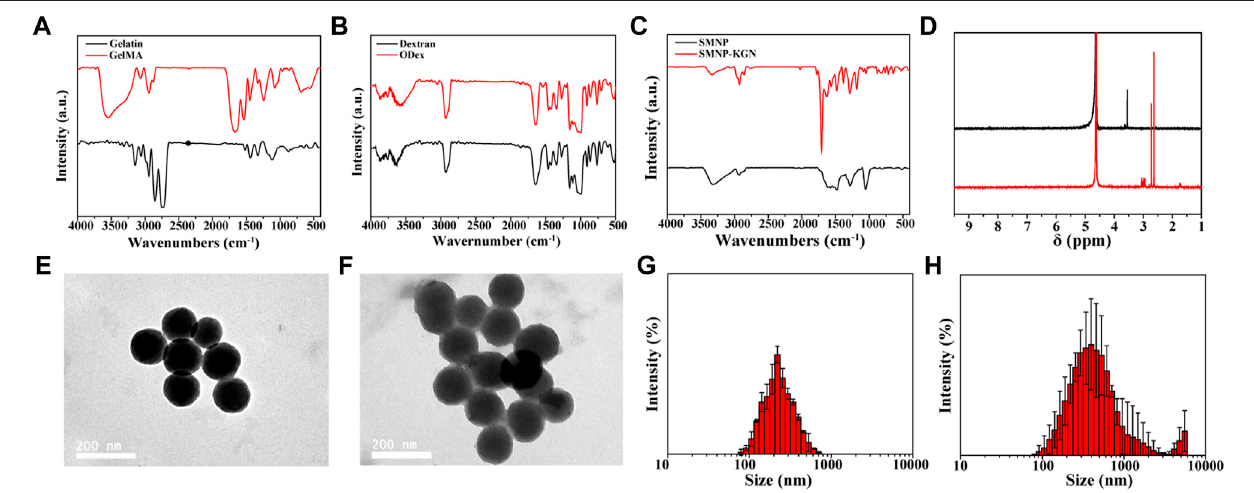
FIGURE1| Chemical construction ofsynthesizedmaterials and characterizationofnanoparticles. (A) FT-IRspectrum ofgelatinand GelMA; (B) FT-IRspectrum of dextran and ODex; (C) FT-IR spectrum of SMNP and SMNP-KGN; (D) 1 H NMR spectrum of SMNP and SMNP-KGN; TEM image of (E) SMNP and (F) SMNP-KGN nanoparticles; hydration diameter statistics of (G) SMNP and (H) SMNP-KGN obtained by dynamic light scattering.